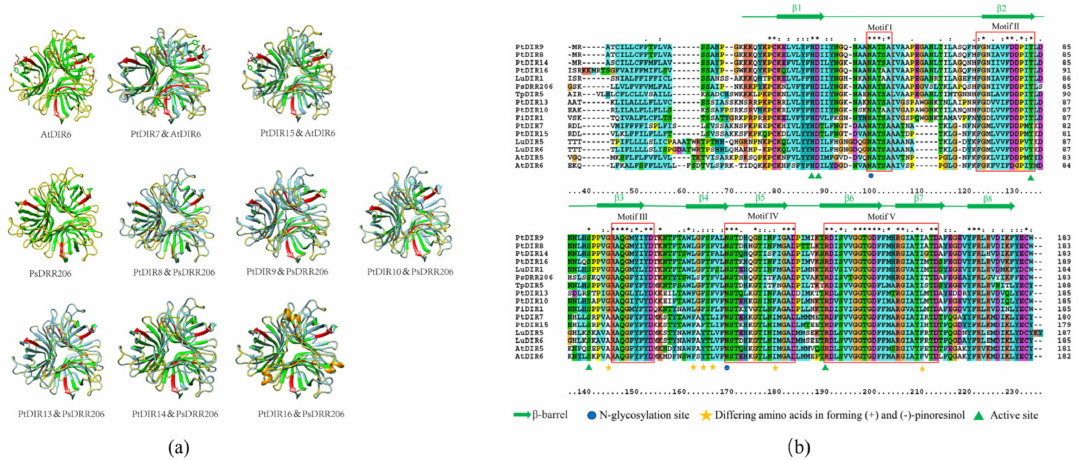
Figure 7. The protein tertiary structures and sequence alignments of PtDIR proteins of the DIR-a subfamily. ( a ) The prediction of the PtDIR7–10, 13, 15, and 16 protein tertiary structures of the DIR-a subfamily compared and merged with AtDIR6 (associated with ( − ) pinoresinol) and PsDRR206 (associated with (+) pinoresinol), respectively. ( b ) The alignment of PtDIR protein sequences of the DIR-a